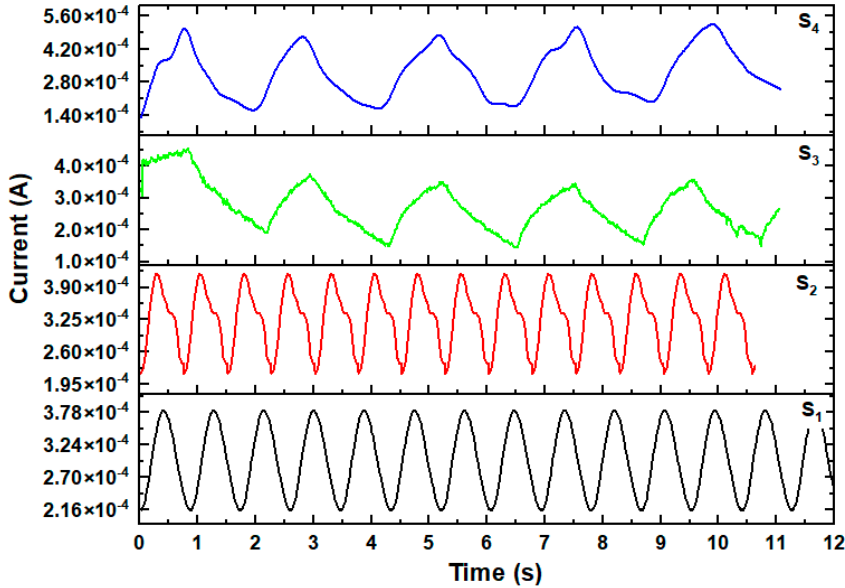
Figure 8. Photocurrent response for a set of photodetector devices S 1 , S 2 , S 3 , and S 4 upon exposure to 365 nm light at +3 V bias voltage.